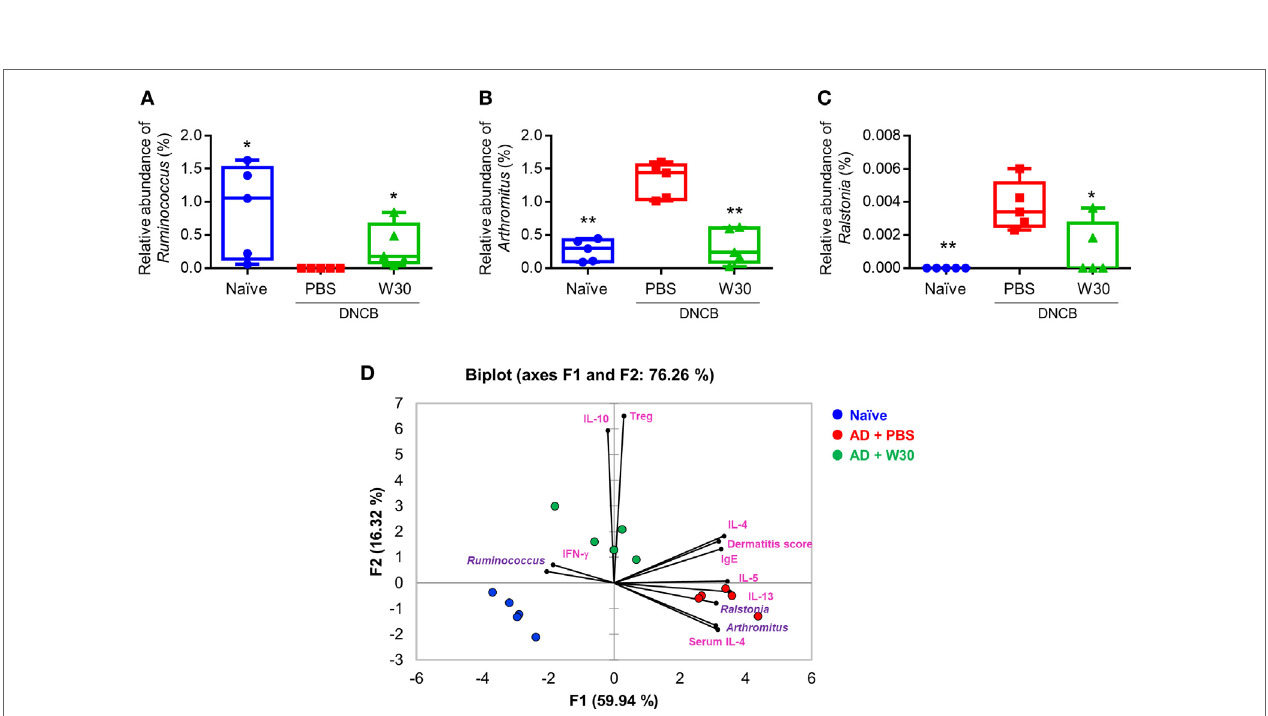
FigUre 6 | Effect of WIKIM30 on gut microbiota composition. Composition of the gut microbiota in normal mice and in atopic dermatitis (AD) mice without or with WIKIM30 treatment. (a–c) Relative abundance of Ruminococcus , Arthromitus , and Ralstonia in each group. Student’s t -test (unpaired); * p < 0.05, ** p < 0.01 vs. AD group. (D) Correspondence analysis of fecal microbiome composition and immune response. Naïve, normal mice (blue); AD, DNCB-induced AD mice (red); W30, DNCB-induced AD mice with oral administration of WIKIM30 (green).